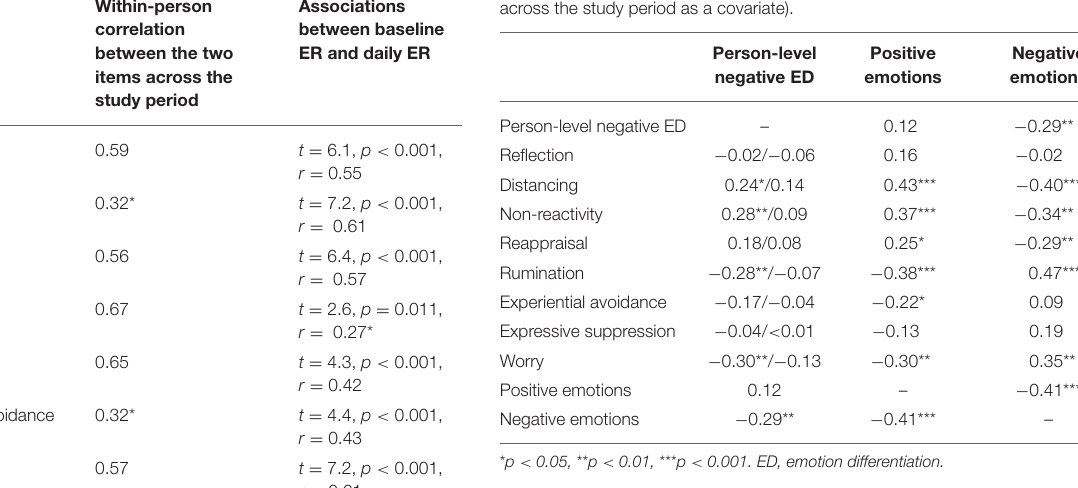
TABLE 2 | Associations expressed as correlation coefficients between emotion regulation at baseline, person-level emotion differentiation, and negative and positive emotions at baseline (without/with mean levels of negative emotions across the study period as a covariate).